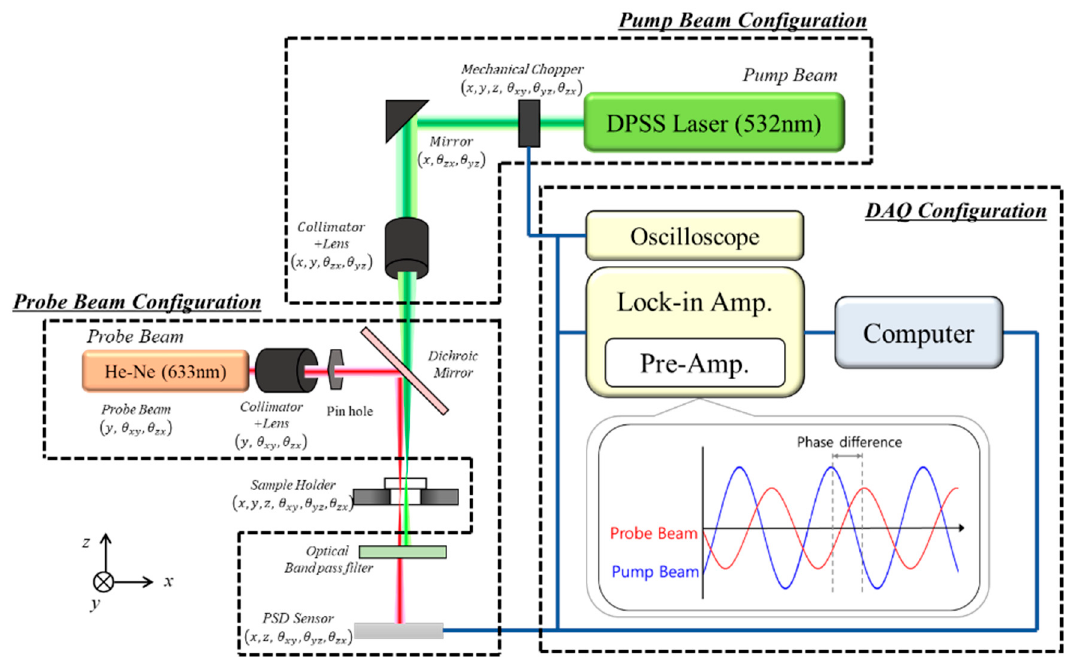
Figure 6. Schematic of experimental setup.